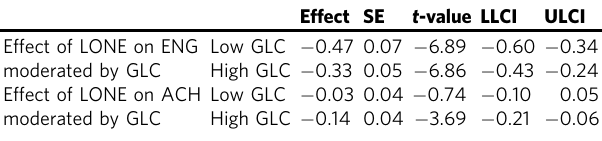
Table 5 Moderating effect of the God locus of control. Conditional effects of the focal predictor at values of the moderator(s):